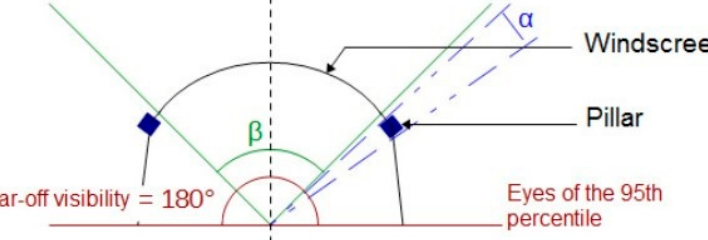
Figure 4. Driver sight line studies.